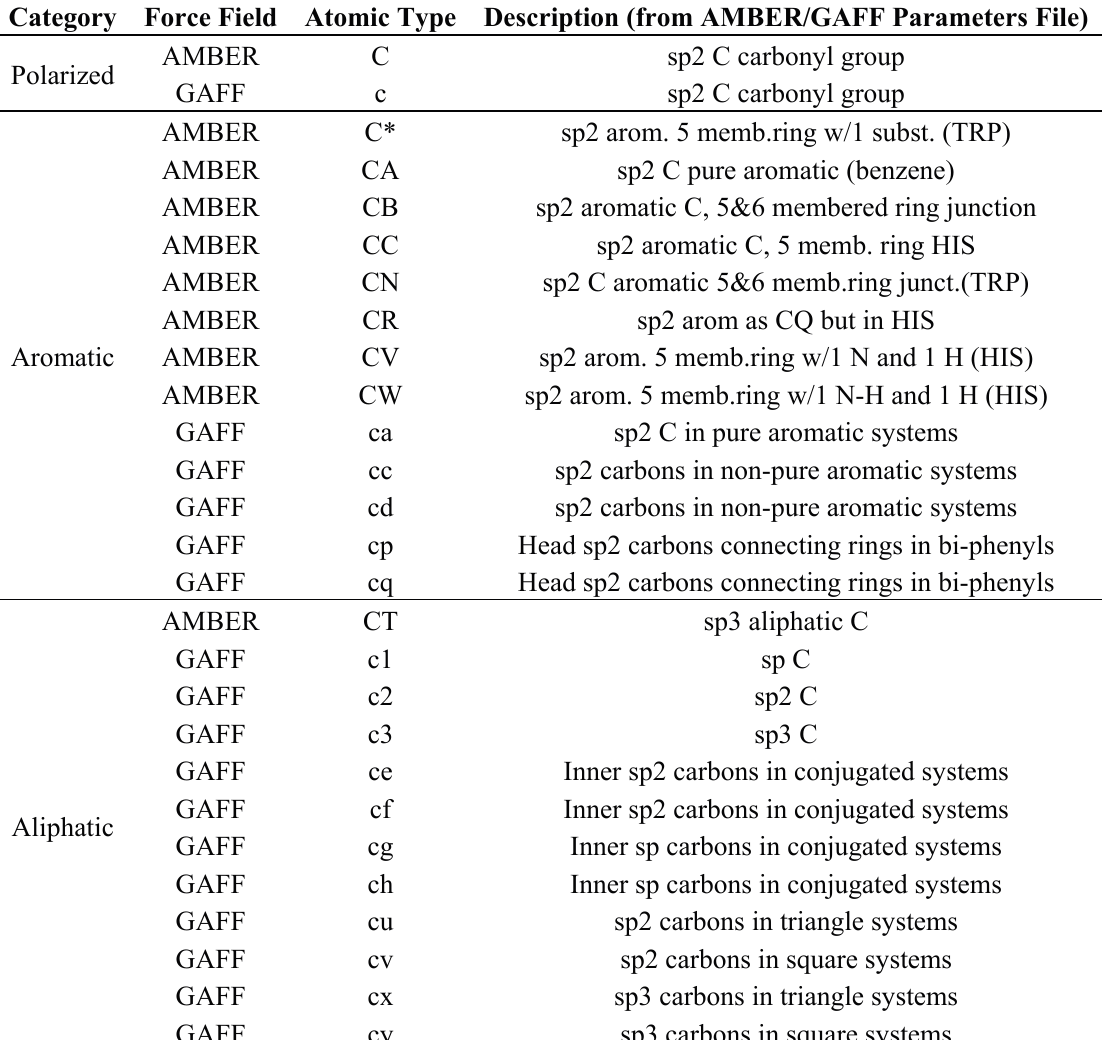
Table 1. Description of the AMBER/GAFF carbon types and their